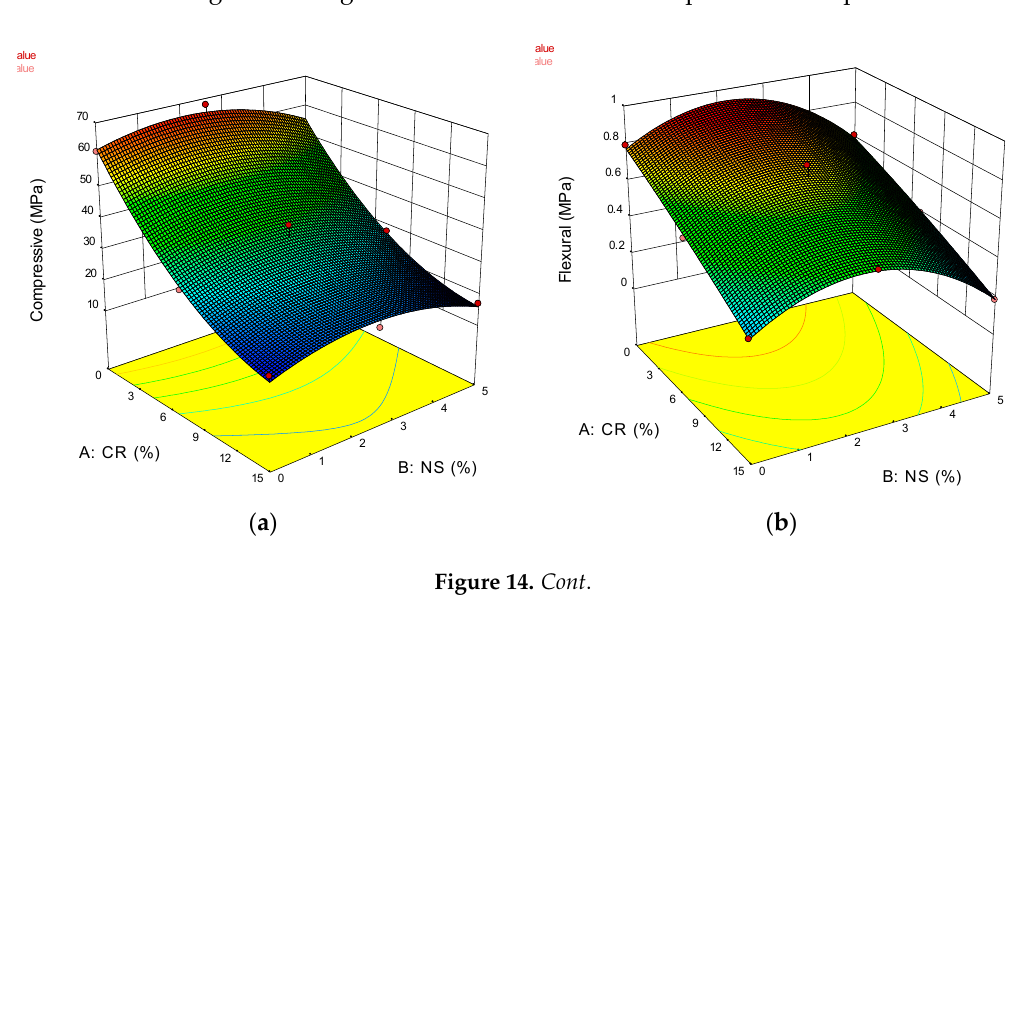
Figure 13. 2D contour plots for developed response models: ( a ) Compressive Strength; ( b ) Flexural Tensile Strength; ( c ) Direct Tensile Strength; ( d ) Drying Shrinkage; ( e ) Modulus of Elasticity; ( f ) Poisson’s Ratio. A 3-dimensional (3D) surface plot is a projection of the contour plot giving shape in addition to color and contour, as illustrated in Figure 14. It was observed that CR exhibited higher and negative effects on most of the responses as compared to NS.